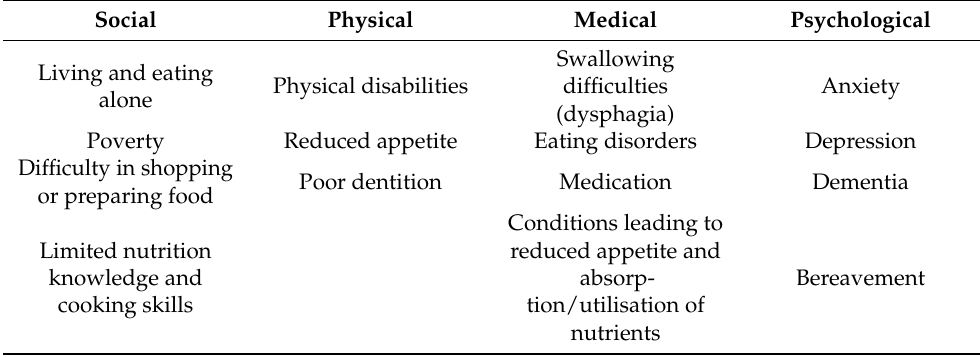
Table 1. Suggested risk factors for malnutrition (adapted from